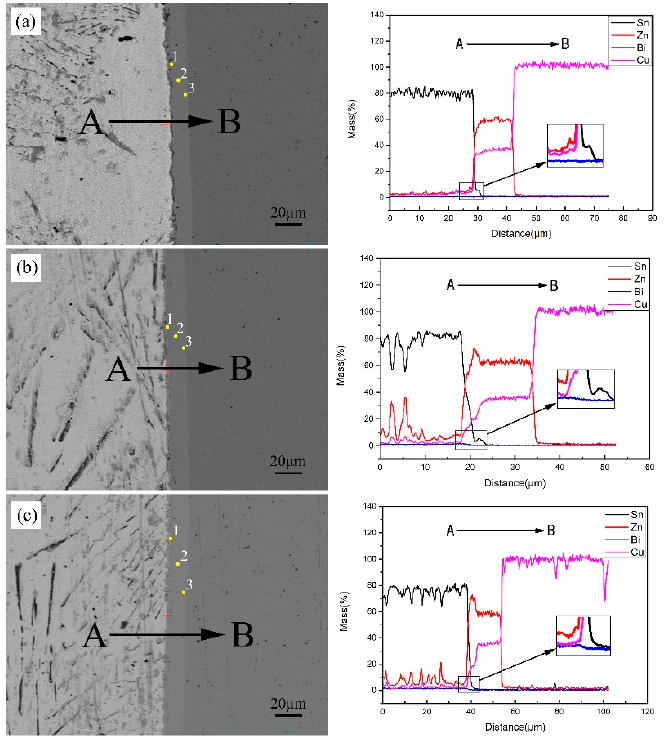
Figure 12. EPMA images and line analyses of the interface of Sn-9Zn-xBi/Cu joints: ( a ) x = 0; ( b ) x = 1; ( c ) x = 2.